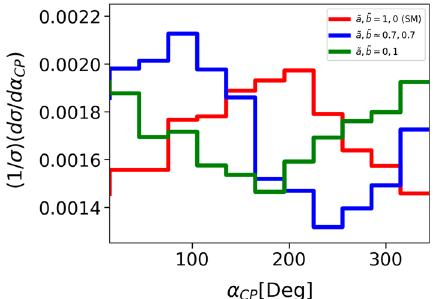
Fig. 8 Here we present the distribution of the α CP after the detector simulation. The red, blue and green distributions represent the CP - phase zero, π/ 4 and π/ 2 respectively. Evidently the α CP observable